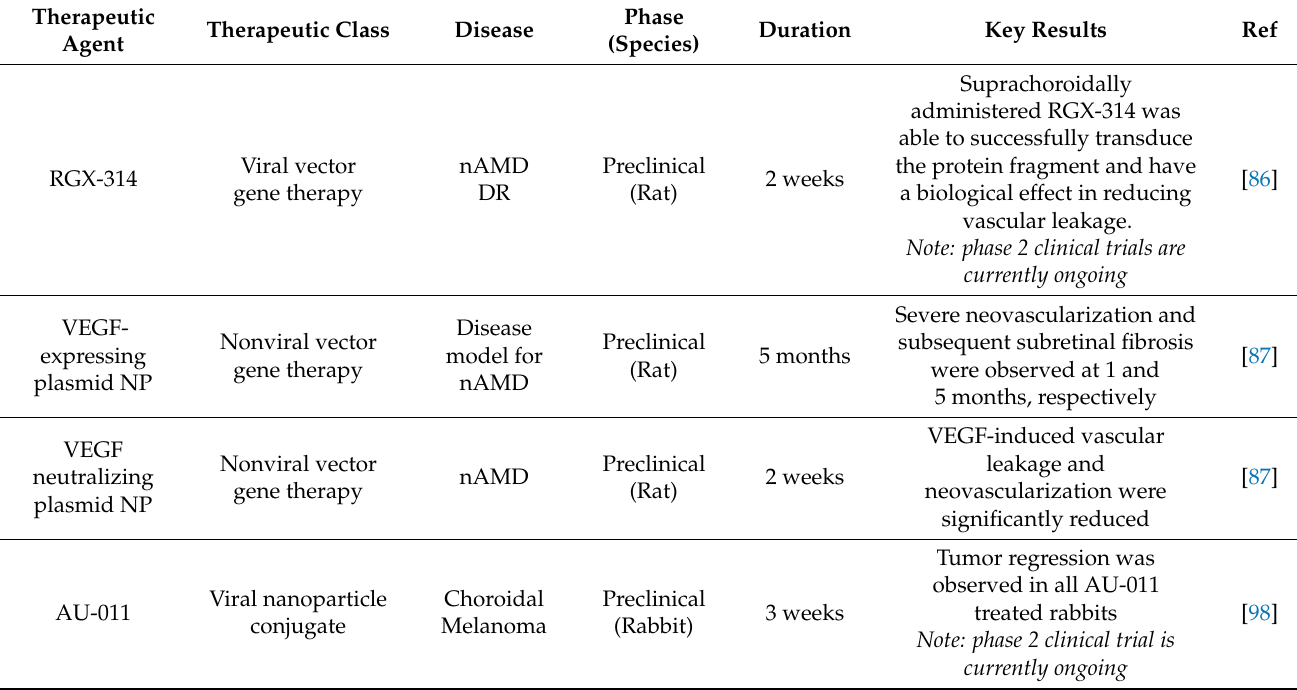
Table 3. Summary of Preclinical and Clinical Investigations of Gene Therapies Administered into the Suprachoroidal Space.